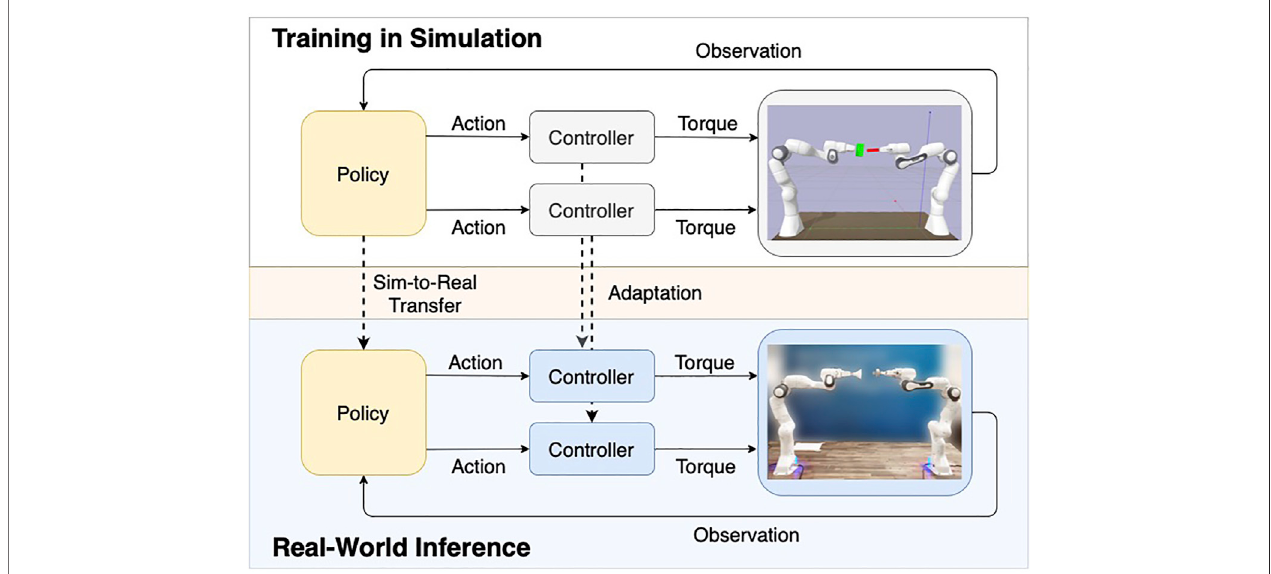
FIGURE2| Thediagramgivesanoverviewofourmethodbyshowingtheinteractionbetweenpolicy,controllers,robots,andtheenvironments(simulationandreal world). Our framework uses two decentralized single-arm controllers to avoid modeling the task-speci fi c system dynamics and relies on a centralized policy to account for the overall interaction. Based on this architecture, we train our policy in simulation and zero-shot transfer it to the real-world environment. The sim-to-real transfer requires only minor adaptations of the controller parameters, as illustrated by the dashed line.